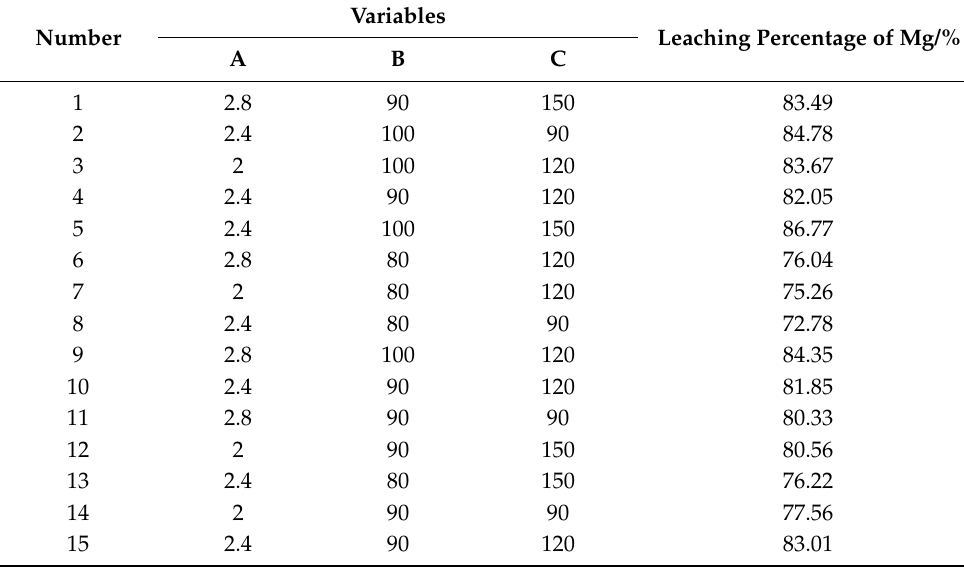
Table 4. Experimental scheme and results from the response surface designed experiment.